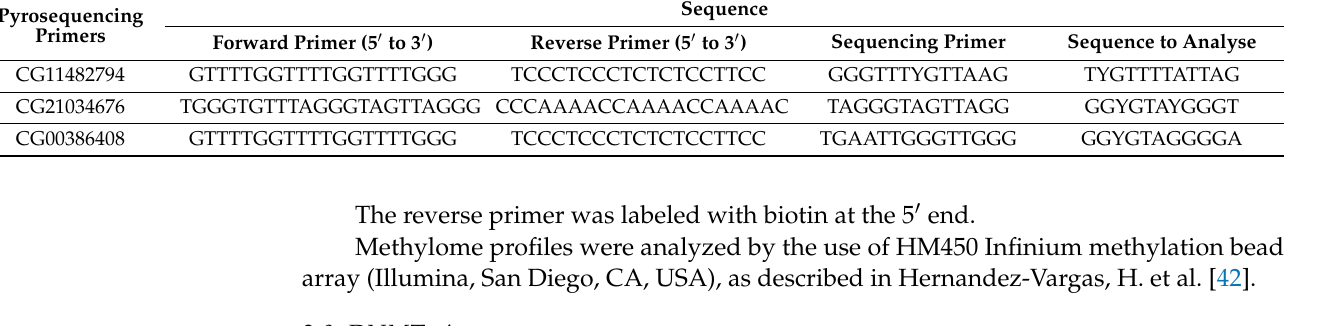
Table 2. Primers used for pyrosequencing (sequence of primers 5 (cid:48) -3 (cid:48) ). Pyrosequencing Primers